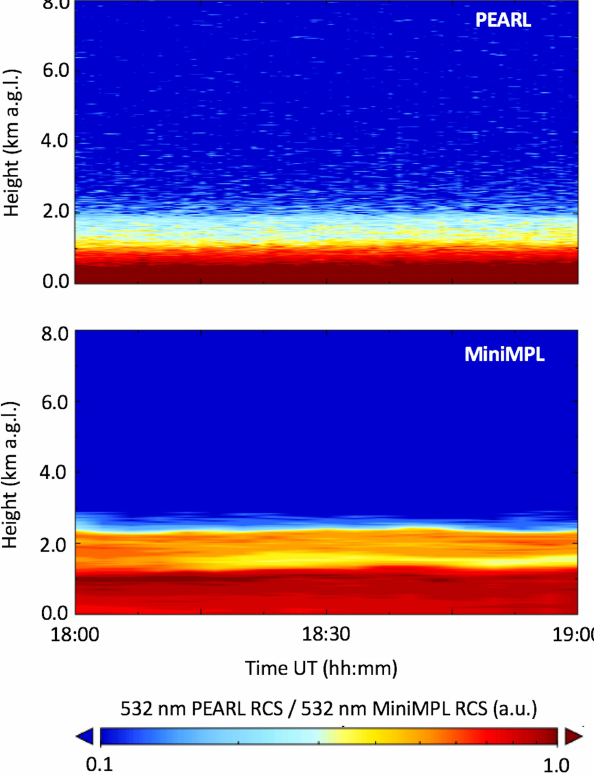
Figure 1. Time series of 532nm range-corrected signal (RCS) mea- sured with PEARL and MiniMPL on 13 October 2016 from 18:00 to 19:00UT; heights are above ground level (a.g.l.); raw time and vertical resolutions are 1min and 15m for PEARL and 5min and 30m for MiniMPL. The color scale shown at the bottom is logarith-